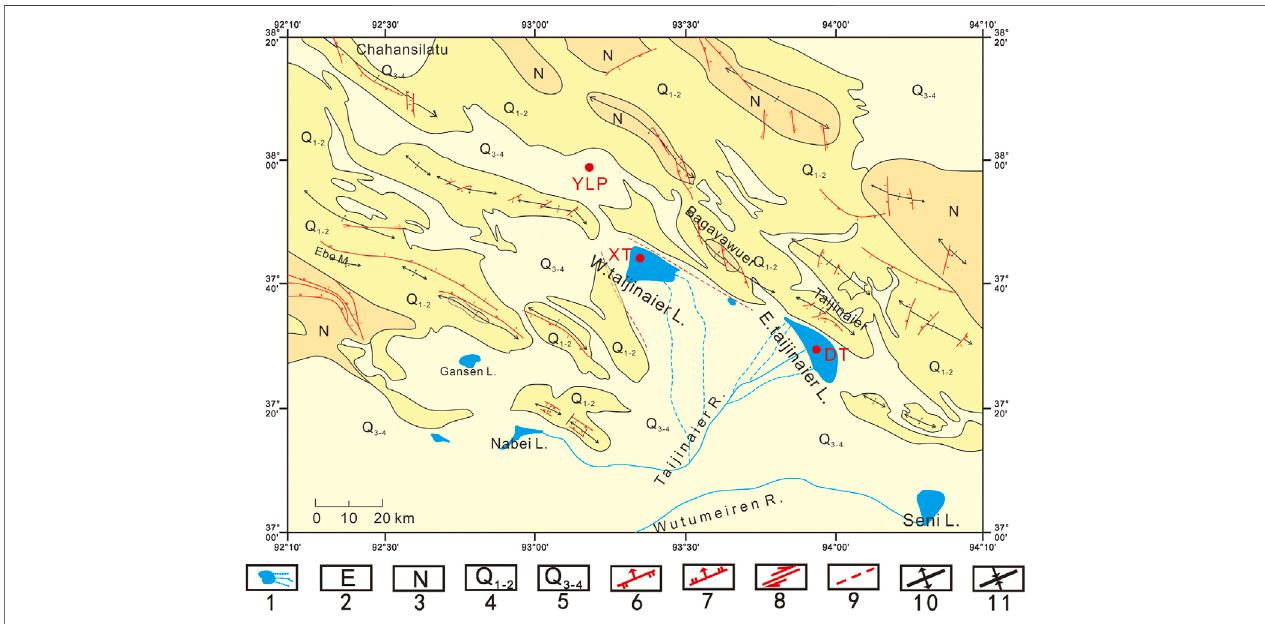
FIGURE3| Map ofmajortectonic and sedimentologicfeatures.Legend: 1.Lakes and rivers;2. Neogene; 3. Palaeogene; 4.EarlyPleistocene-Middle Pleistocene; 5. Epipleistocene – Holocene; 6. Reverse fault; 7. Normal fault; 8. Trike-slip fault; 9. Fault observed by remote sensing; 10. Anticline; and 11. Syncline. Study sites are marked with red dots.